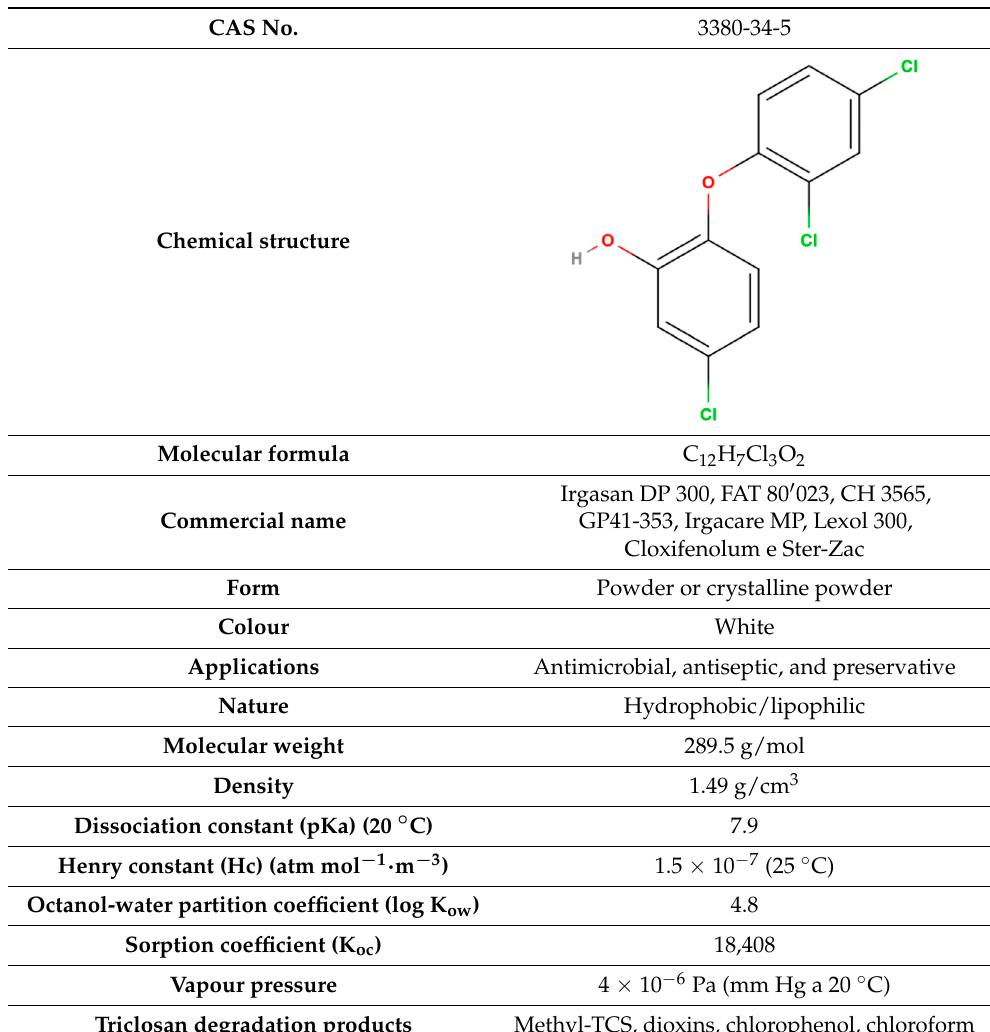
Table 1. Triclosan general properties [26–29].